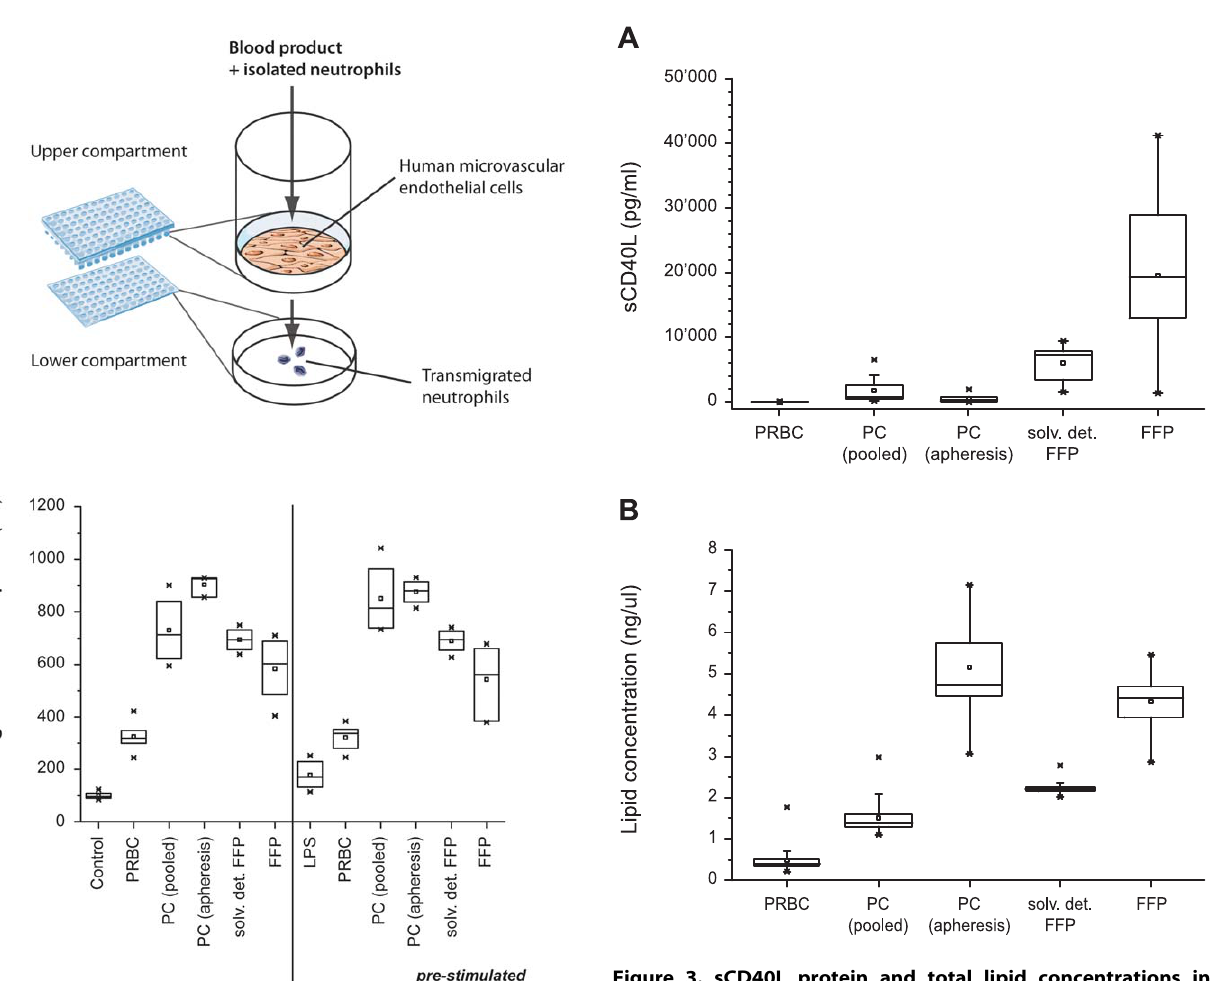
Figure 3. sCD40L protein and total lipid concentrations in different blood products. Concentration of soluble CD40 ligand (sCD40L) (A) and total lipids (B) in packed red blood cells (PRBC), platelet concentrates (pooled and apheresis), solvent detergent or untreated fresh frozen plasma (FFP). Blood products were collected and centrifuged at 1500 rpm. Supernatants were analyzed with enzyme- linked immunosorbent assays for sCD40L, concentrations of lipids were determined using the sulfo-vanillin colorimetric method. Results are shown as medians with interquartile ranges.